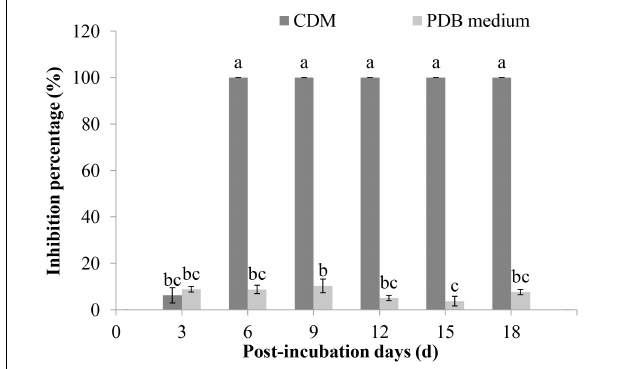
FIGURE 2 | Inhibition rates of V. dahliae by the culture filtrates of F. proliferatum 10R-7 in CDM (Czapek–Dox medium) and PDB medium at different culture times.